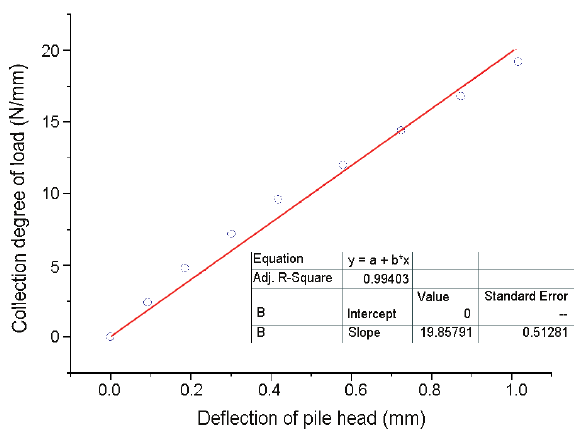
Fig. 7. Fitting relationship curve between composite elastic modulus and reinforcement